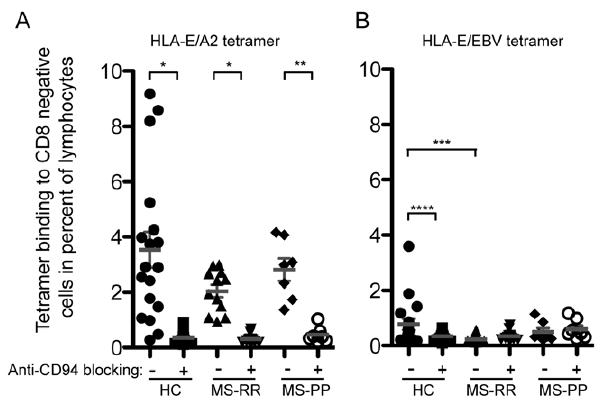
Figure 5. Decreased binding of HLA-E/BZLF1 to CD8-negative cells in MS-RR patients. Tetramer binding of HLA-E/A2 (A) and HLA- E/BZLF1 (B) to CD8-negative cells is shown in percentage of lymphocytes (lymphogate). Binding is analysed in the presence or absence of anti-CD94 blocking antibody. Comparisons between presence and absence of anti-CD94 are done using paired T-test. Other comparisons are done using Mann-Whitney U-test. The sym- bols indicating different p values are: * p # 0.0001, ** p # 0.0008, *** p # 0.0017, **** p # 0.048.